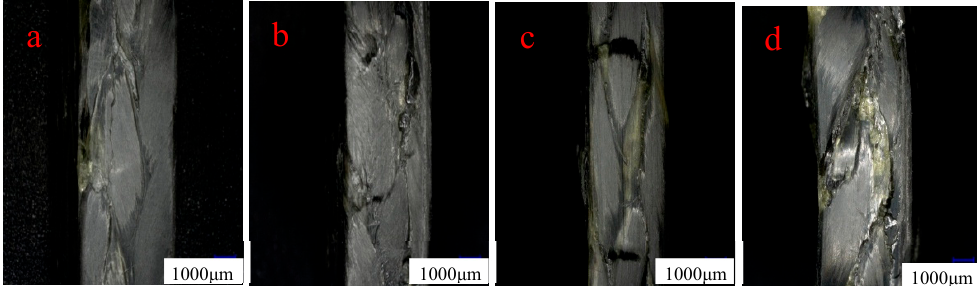
Figure 14. Lateral morphology of bending fracture of the specimens at different temperatures (30 times magnification) ( a ) at room temperature; ( b ) 90 °C 0.25 h; ( c ) 110 °C 0.25 h; ( d ) 150 °C 0.25 h.